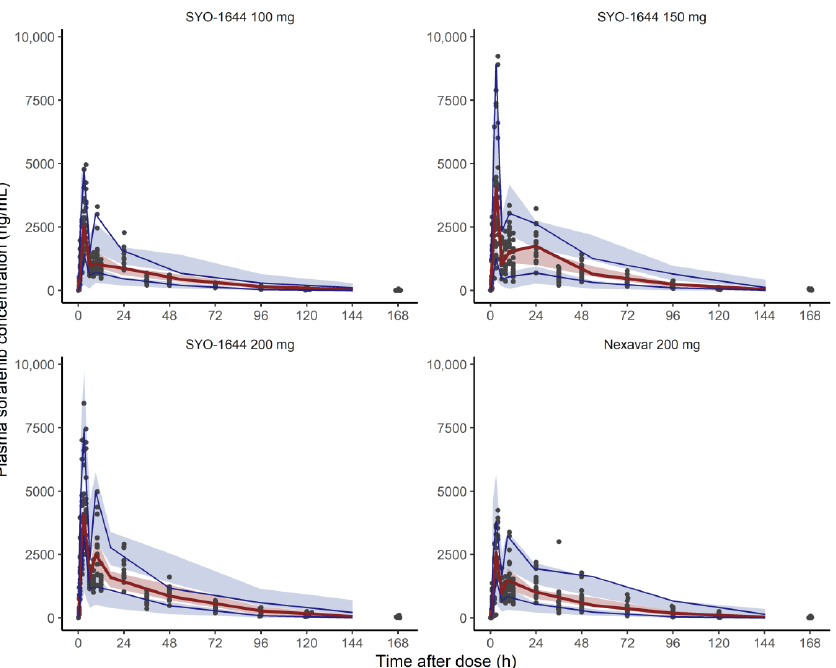
Figure 4. Visual predictive check results for the final population pharmacokinetic model. Solid blue lines represent 5th and 95th percentile for observed data. Solid red line represents median for observed data. Blue areas represent 95% confidence intervals for 5th and 95th percentile of simulated data. Red areas represent 95% confidence intervals for median of simulated data.